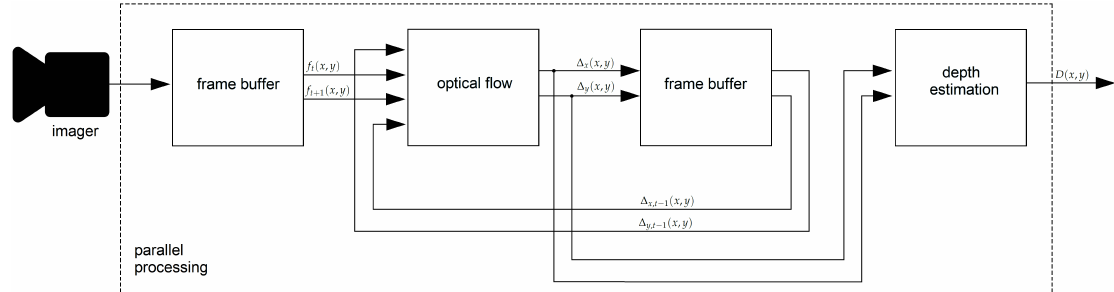
Figure 1. Block diagram of the proposed